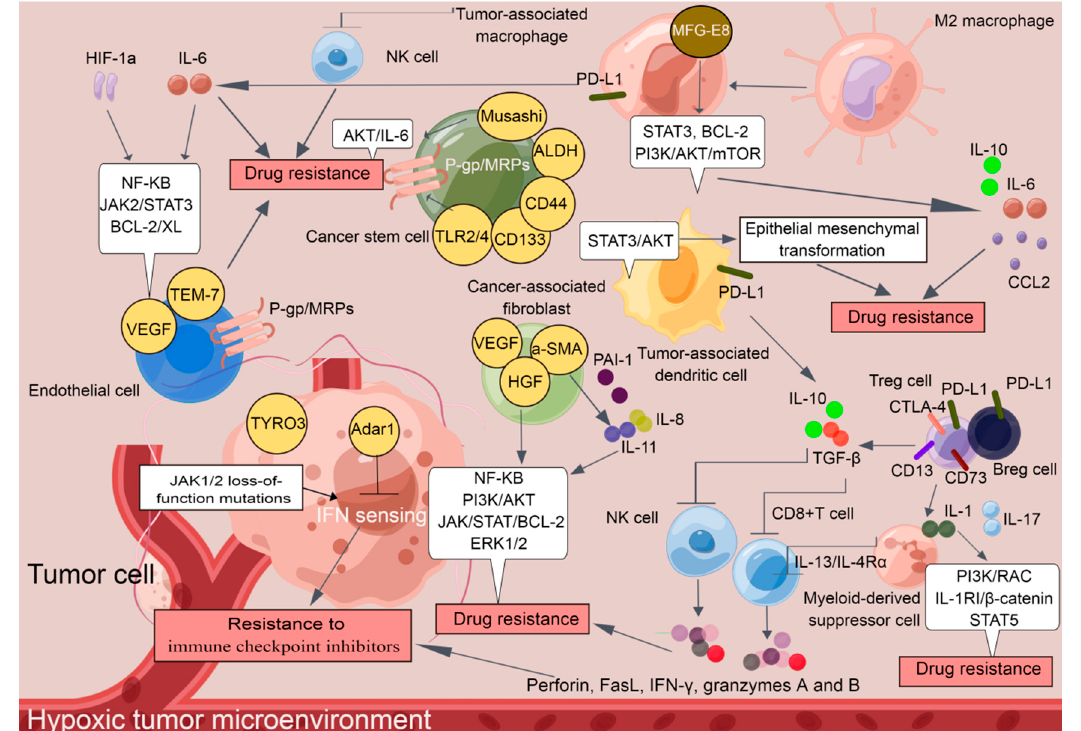
Figure 1. A tumor-supportive TME facilitating the development of drug resistance in tumor cells ( By Figdraw.)